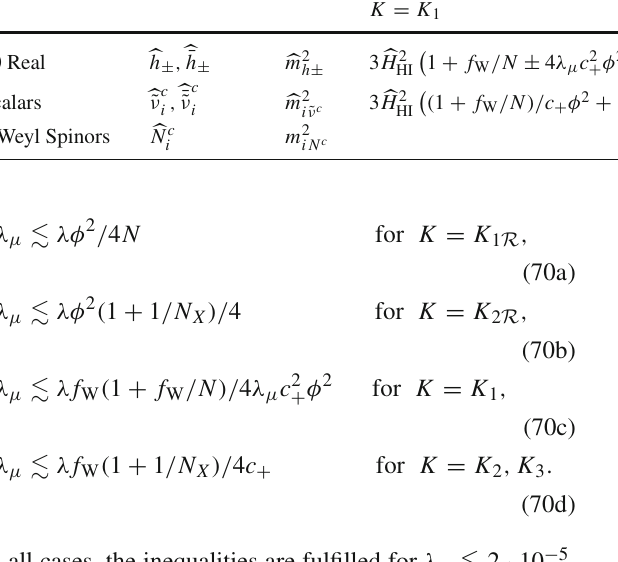
Table 4 The same as Table 3 but for K = K 1 , K 3 and K 3